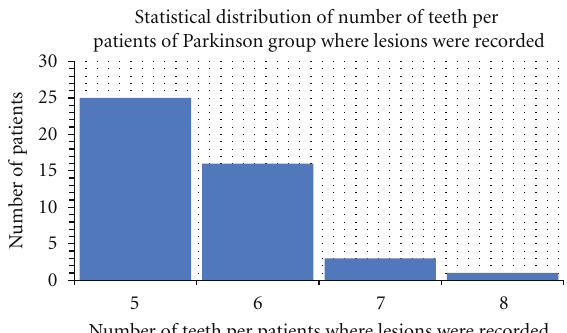
Figure 5: Deep of the sockets recorded in control group. Figure 6: Deep of the sockets recorded in PD group.